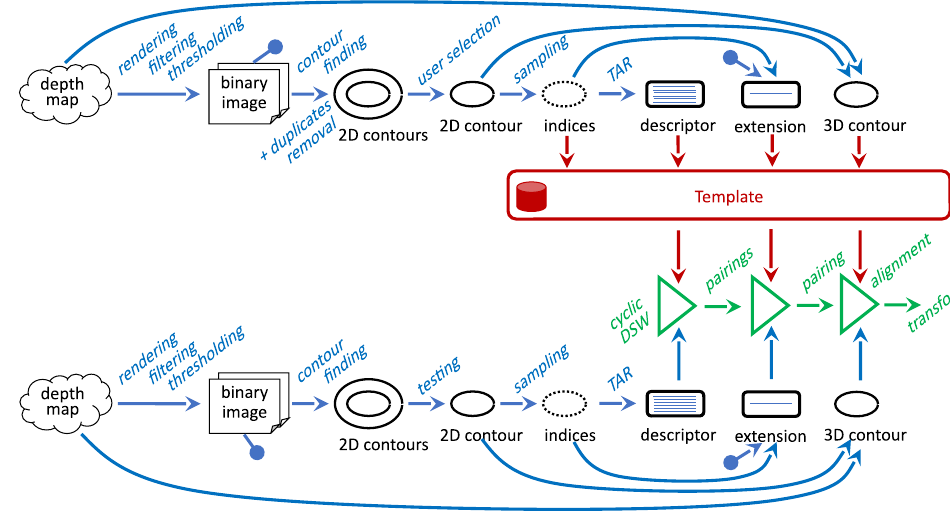
Figure 2. Our processing pipeline for object recognition and